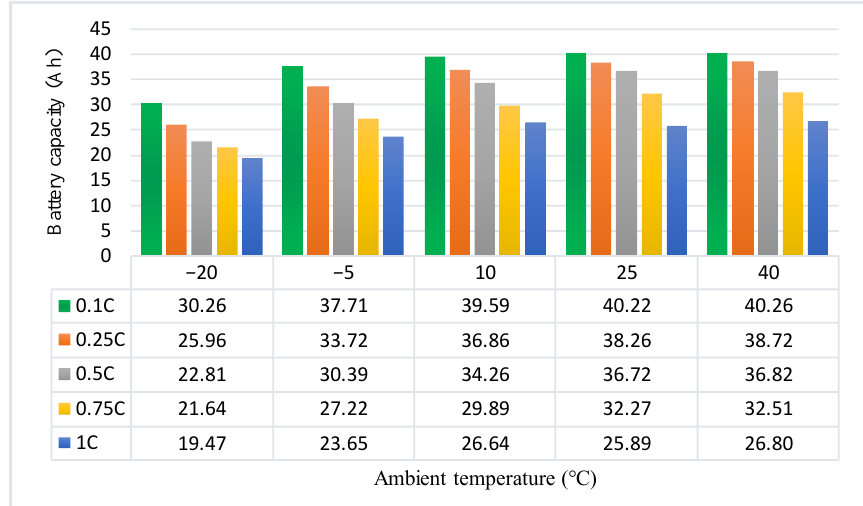
Figure 6. Charge capacity comparison chart.